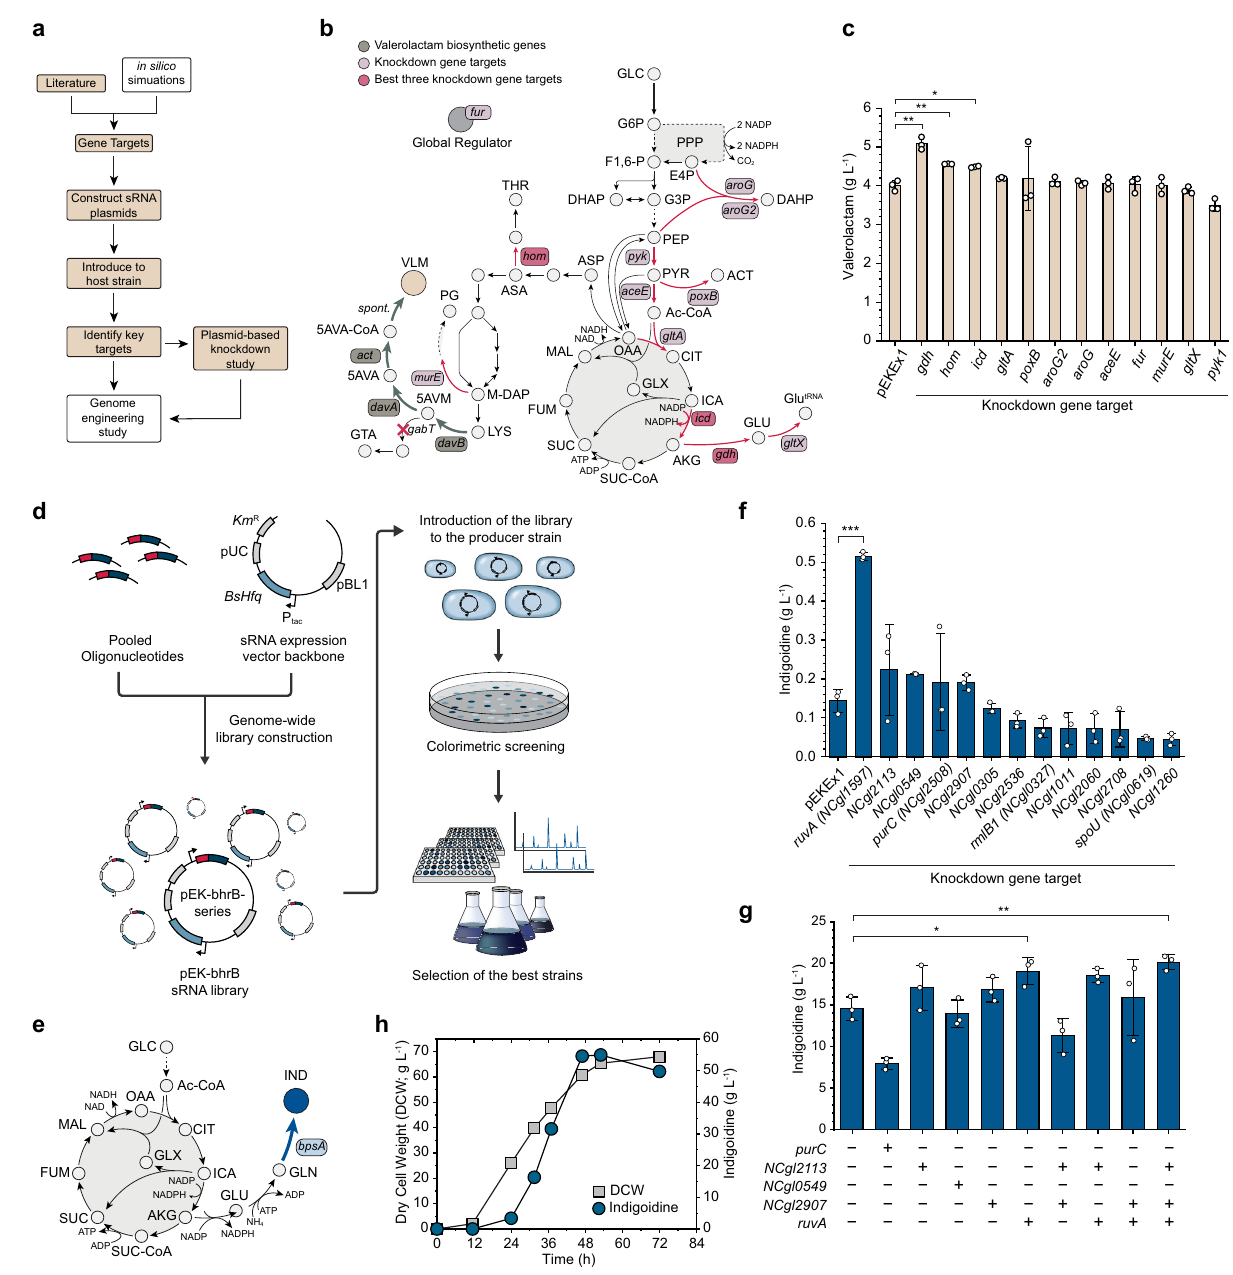
Fig. 3 | Rapid identi fi cation ofgene knockdown targets for enhanced chemical production. a Work fl ow to identify key target genes to enhance valerolactam production in C. glutamicum . Steps employed for the enhanced production of valerolactam are described in fi lled rectangles. Additional steps that would facil- itatehigh-performingstrainconstructionaredescribedinemptyrectangles,which are exempli fi ed in Supplementary Note 4 for methyl anthranilate production. b Metabolicpathwaysforthebiosynthesisofvalerolactam,illustratingtargetgenes selected (light pink boxes) and experimentally validated target genes that showed enhanced valerolactam production. Red ‘ X ’ denotes gene knockout; Red arrows represent reactions selected for knockdown. Dark green arrows represent het- erologous reactions introduced. Abbreviations in Supplementary Note 5. c Valer- olactam production titers obtained by the knockdown of the screened 12 gene targets. Error bars, mean±SD ( n =3 biologically independent samples). * P <0.017, ** P <0.0033, *** P <0.00033, determined by two-tailed Student ’ s t -test. P -value thresholds were adjusted using Bonferroni correction ( P < α / m ). Enzymes that encode the genes listed are provided in Supplementary Table 6. d